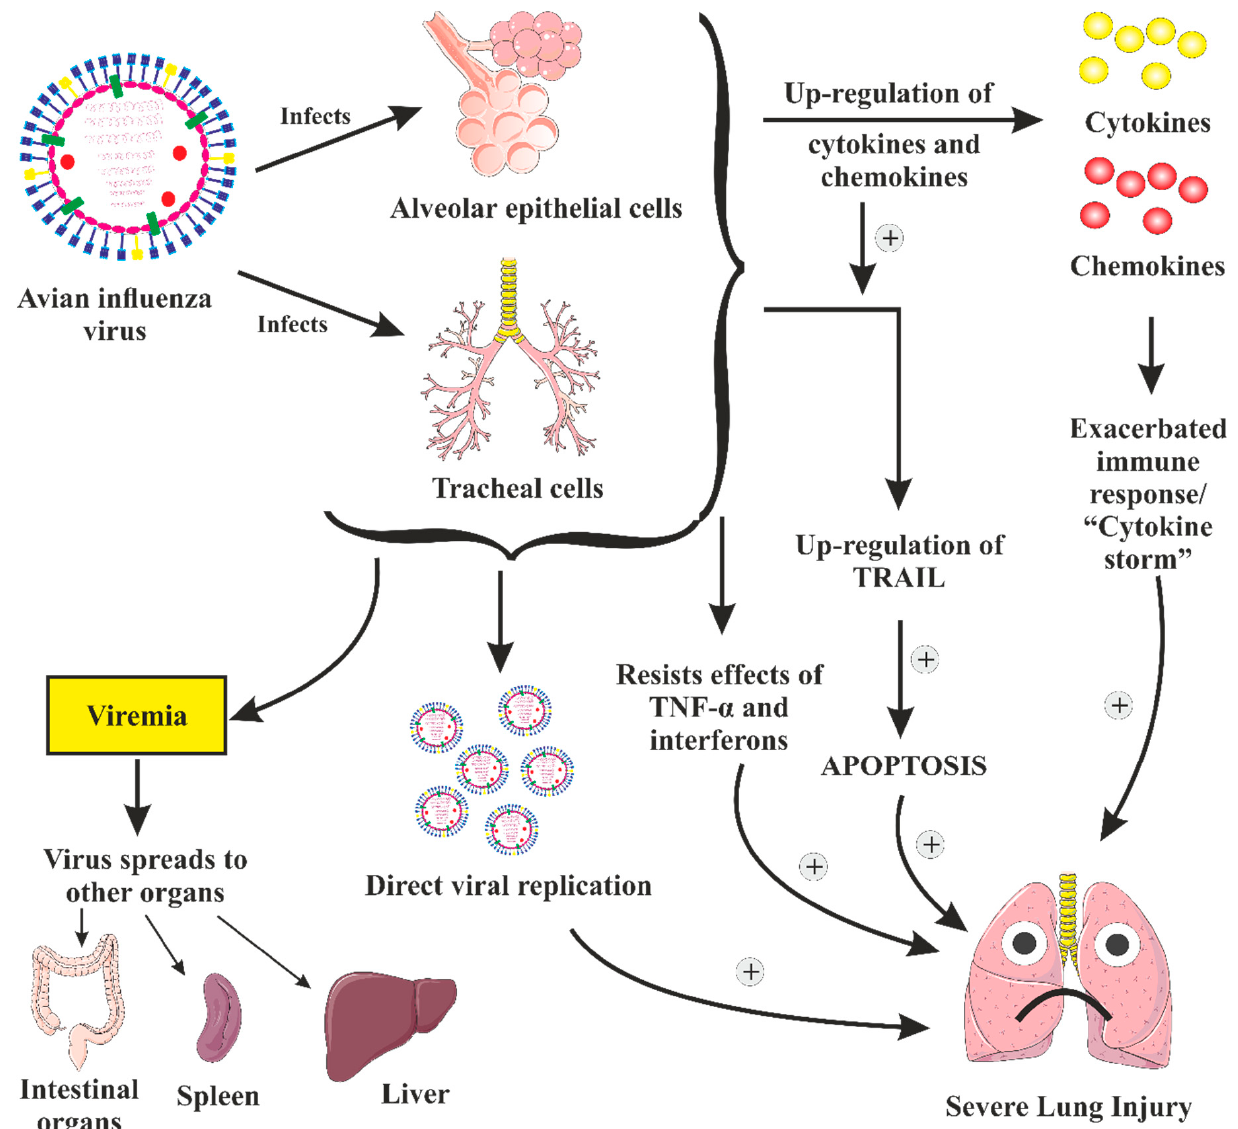
Figure 6. Pathogenesis of H5N1 virus infection. Virus infects alveolar and tracheal cells, and induces up-regulation of pro-inflammatory cytokines, leading to an aberrant and exacerbated immune response/”Cytokine storm”, which contributes to induction of severe lung injury; stimulation of cytokines and chemokines also activates TRAIL, which leads to apoptosis of infected cells and macrophages, thus leading to lung damage; direct viral replication in the body also contributes to induction of severe lung injury; infection of alveolar and tracheal cells prompts the dissemination of infection to immune cells (viremia), which leads to spread of infection to other organs of the body such as intestinal organs, spleen and